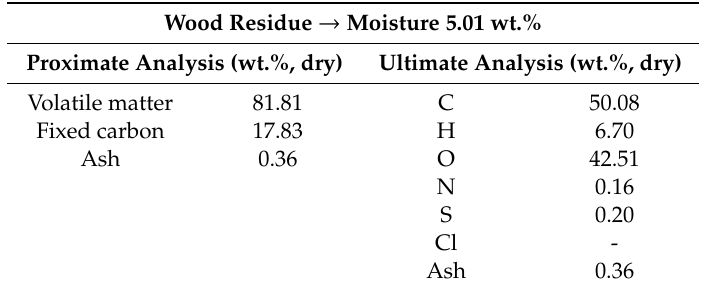
Table 3. Proximate analysis and ultimate analysis inserted in the model